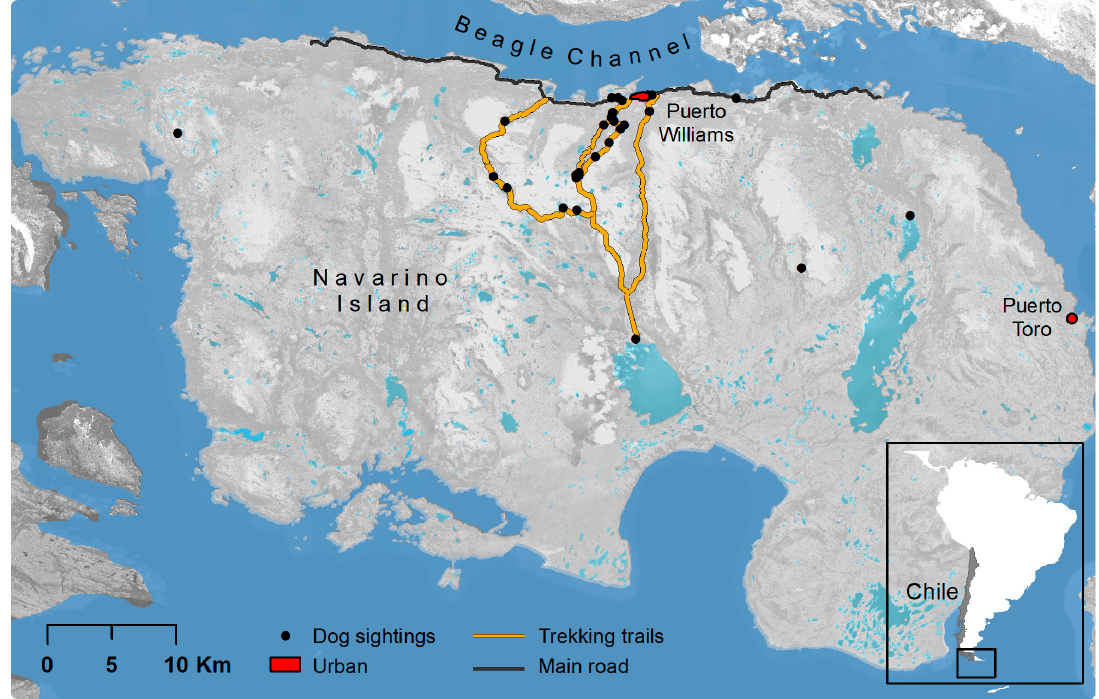
Figure 1. Study area of Navarino Island, Cape Horn Biosphere Reserve, southern Chile. The map highlights the near ‐ pristine character of the island (the only settlements are Puerto Williams and a small fishing town, Puerto Toro) and includes sightings of 58 dogs by 31 tourists (tourist season 2015–2016).